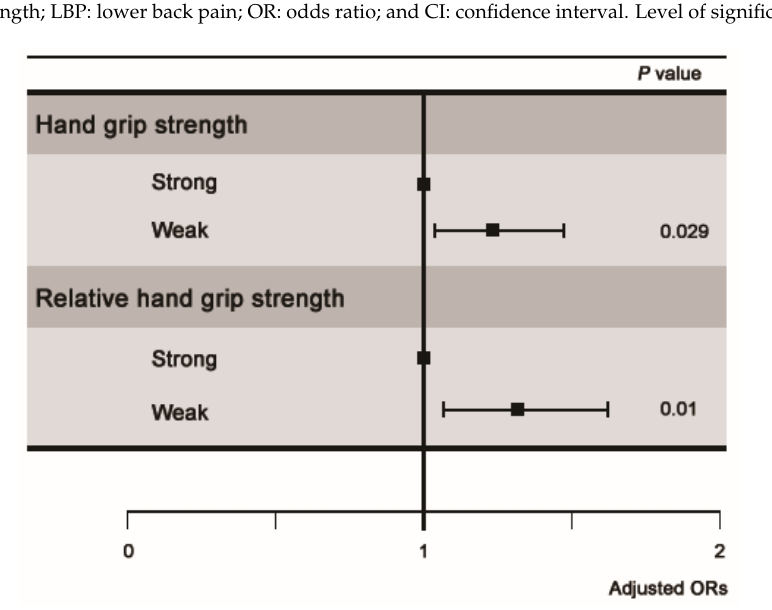
Figure 2. Odds for chronic lower back pain by hand grip strength and relative hand grip strength after adjusting for age, sex, obesity, smoking, alcohol use, education, occupation, income, sleep duration, physical activity, and comorbidities. OR, odds ratio.